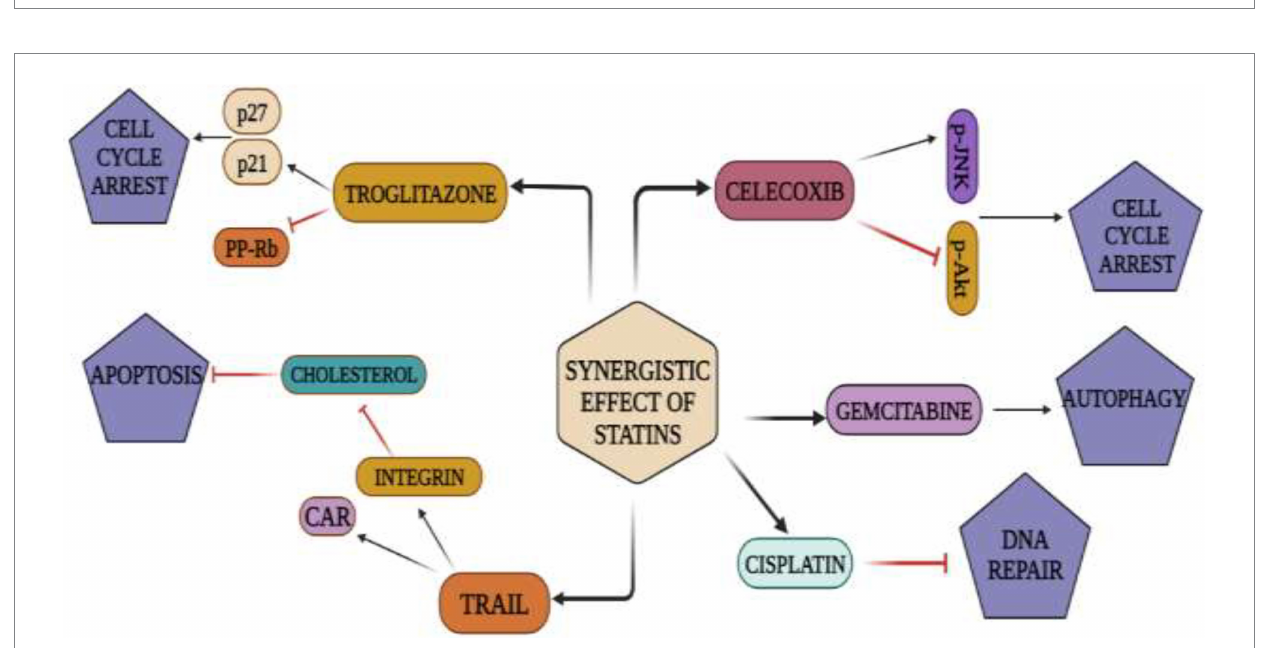
FIGURE 5 Synergistic action of statins and NSAIDs: Statins repress and activate signaling cascades that result in cell-cycle arrest, cell death, apoptosis, and autophagy when used with anti-cancer medications such TRAIL, troglitazone, celecoxib, gemcitabine,